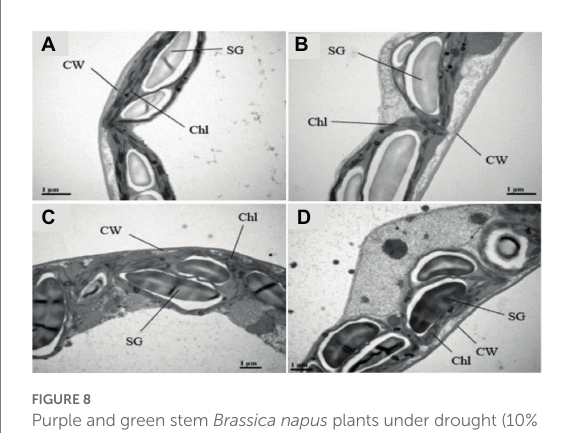
FIGURE 8 Purple and green stem Brassica napus plants under drought (10% PEG-6000), ultrastructure of organelles in mesophyll cells of purple and green stem B. napus seedlings under drought and control conditions Chl (Chloroplast), Thy (Thylakoids), CW (Cell wall), SG (Starch grains) of (A) PS (Ck), (B) PS (PEG), (C) GS (Ck), and (D) GS (PEG), respectively.